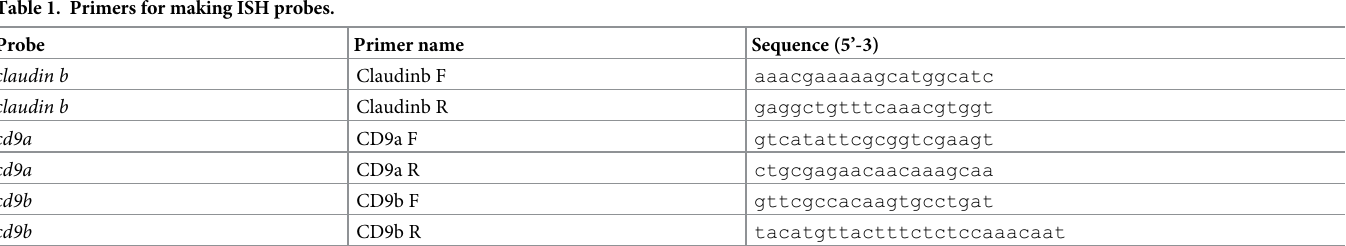
Table 1. Primers for making ISH